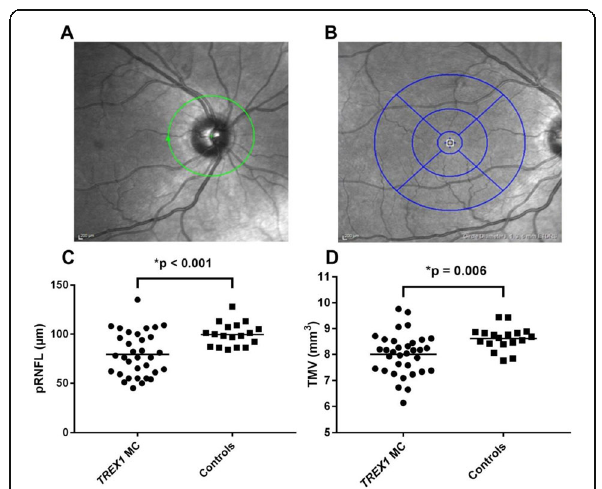
Fig. 1 (abstract P75). Peripapillary retinal nerve fiber layer thickness and total macular volume in TREX1 mutation carriers. Area of measurement peripapillary retinal nerve fiber layer (pRNFL) thickness (A) and total macular volume (TMV) (B). Mean pRNFL (C) and TMV